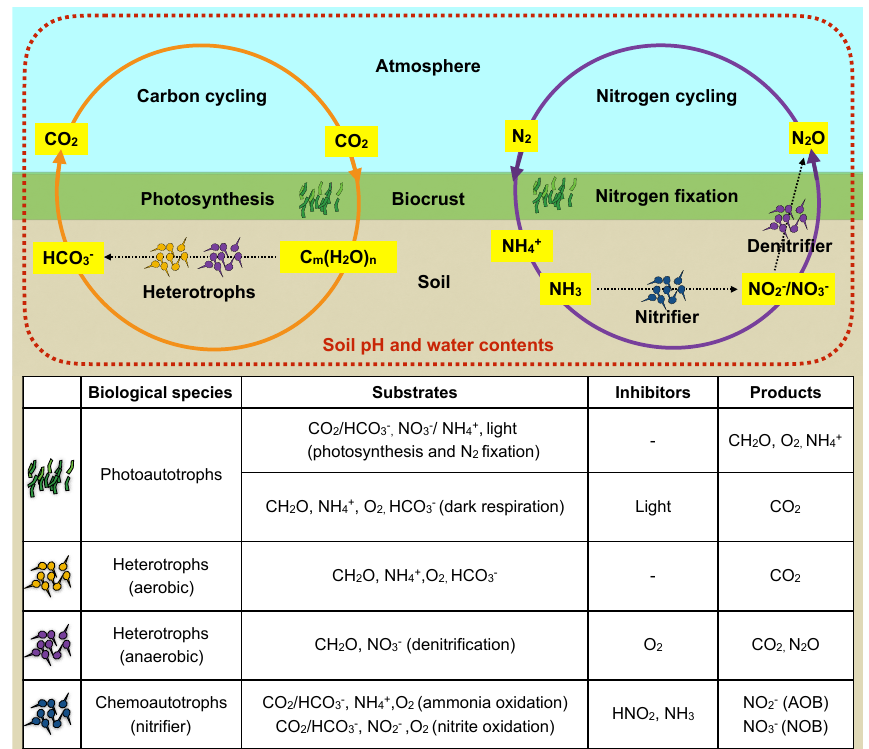
Figure 3. Key microbial functional groups and biogeochemical interactions within the desert biocrust model. The biocrust is considered an ecological unit in which four groups of biological species describe carbon and nitrogen cycling. The introduced chemical and biological species in conjunction with the chemical processes determine the dynamics of the local pH of soil porewater and gaseous efflux at the top of the domain. The growth rate of each species is determined from Eq. (17). For details of stoichiometry, rate expressions, and Monod parameters, see Sect. S4.